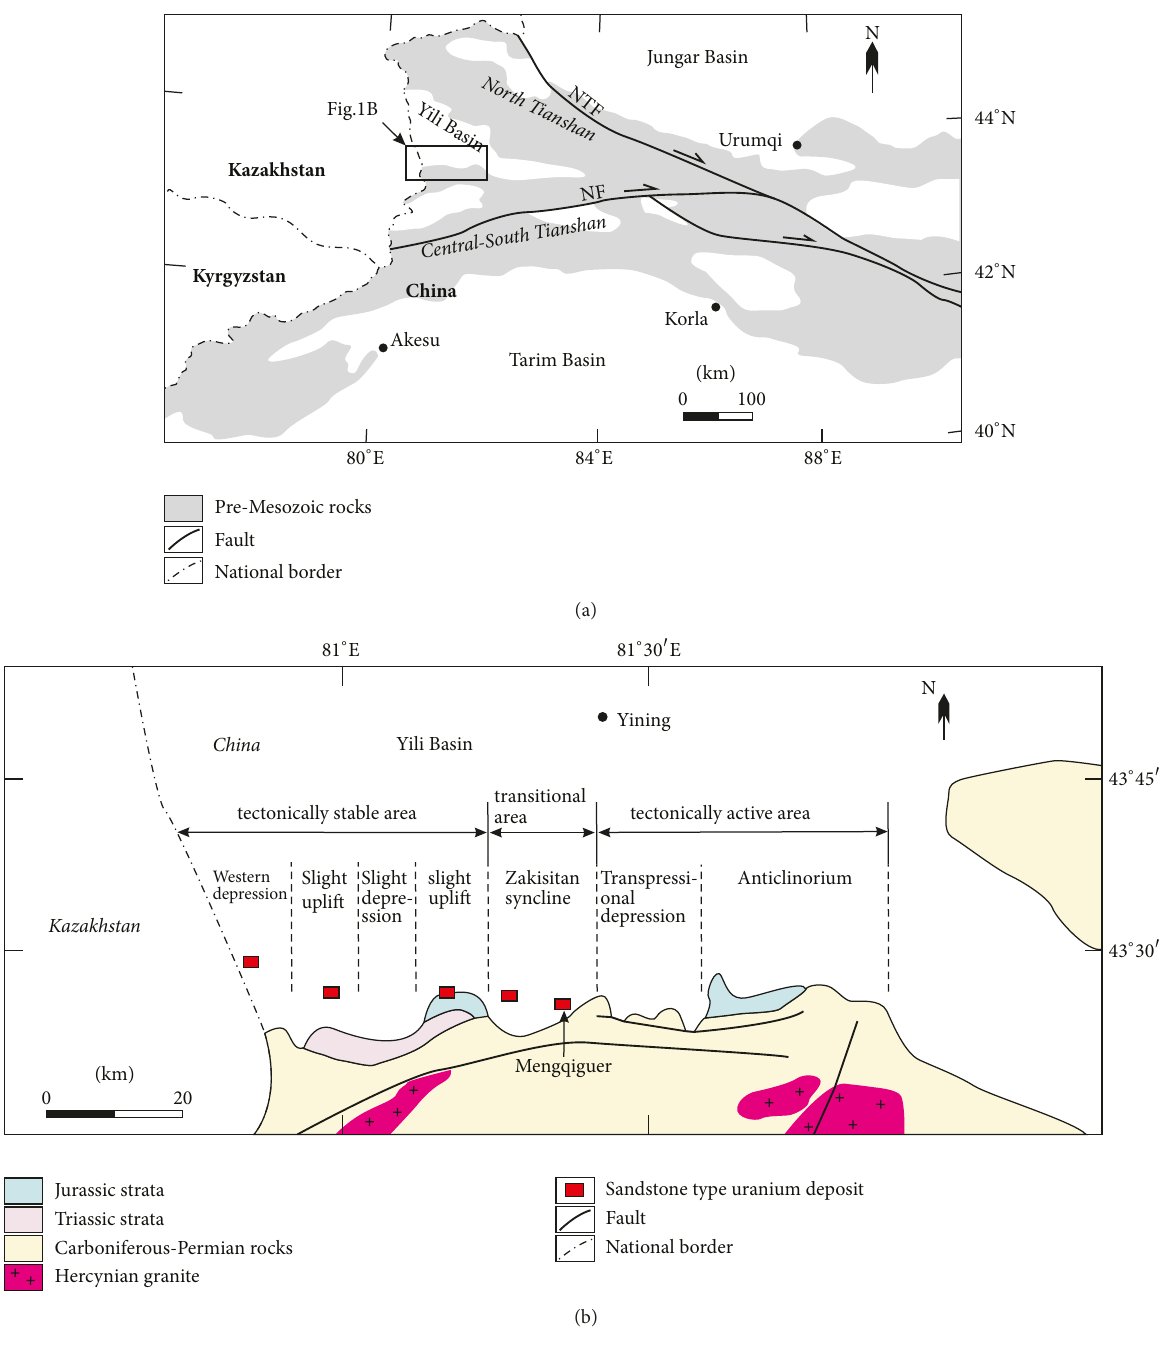
Figure 1: (a) Tectonic sketch map of the Yili Basin. (b) Sandstone-hosted uranium deposit distribution, lithologic units, and tectonic divisions in southern margin of the Yili Basin. All deposits are located in the transitional and tectonically stable areas, which consist of slight uplifts and depressions; in comparison, the tectonically active area contains no deposits. NTF: North Tianshan Fault; NF: Nalati